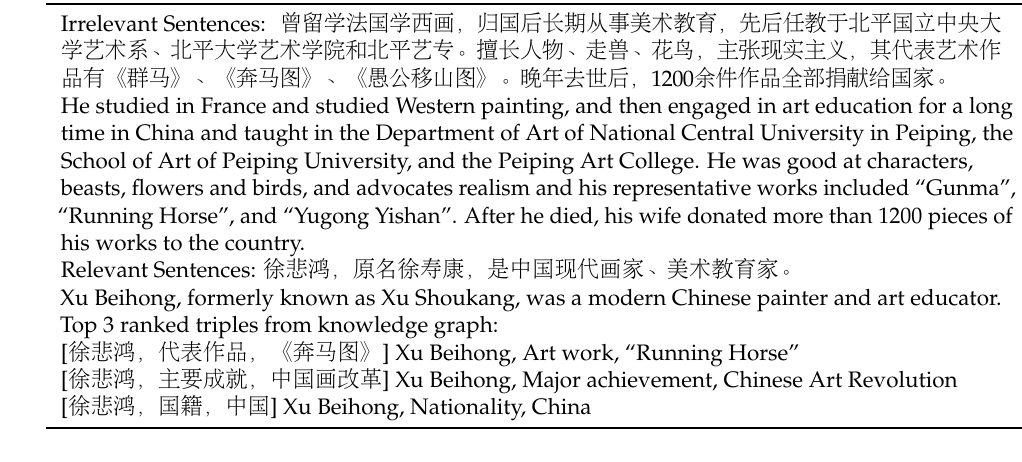
Table 2. An example of compressed passage shown in Table 1 with triples extracted from CN-DBpe- dia2 linking to 徐悲鸿 (Xu Beihong).